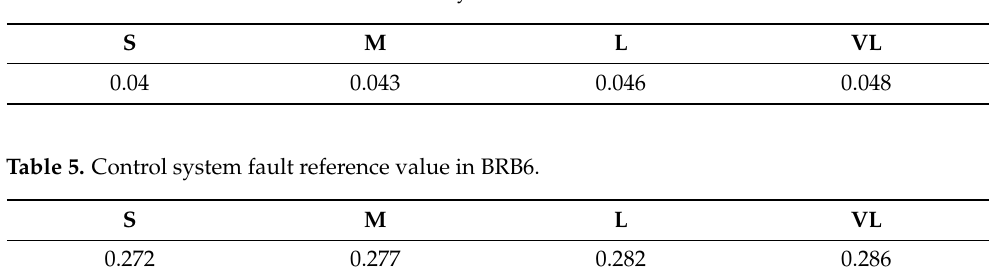
Table 4. Fault reference value of servo drive system in BRB6.